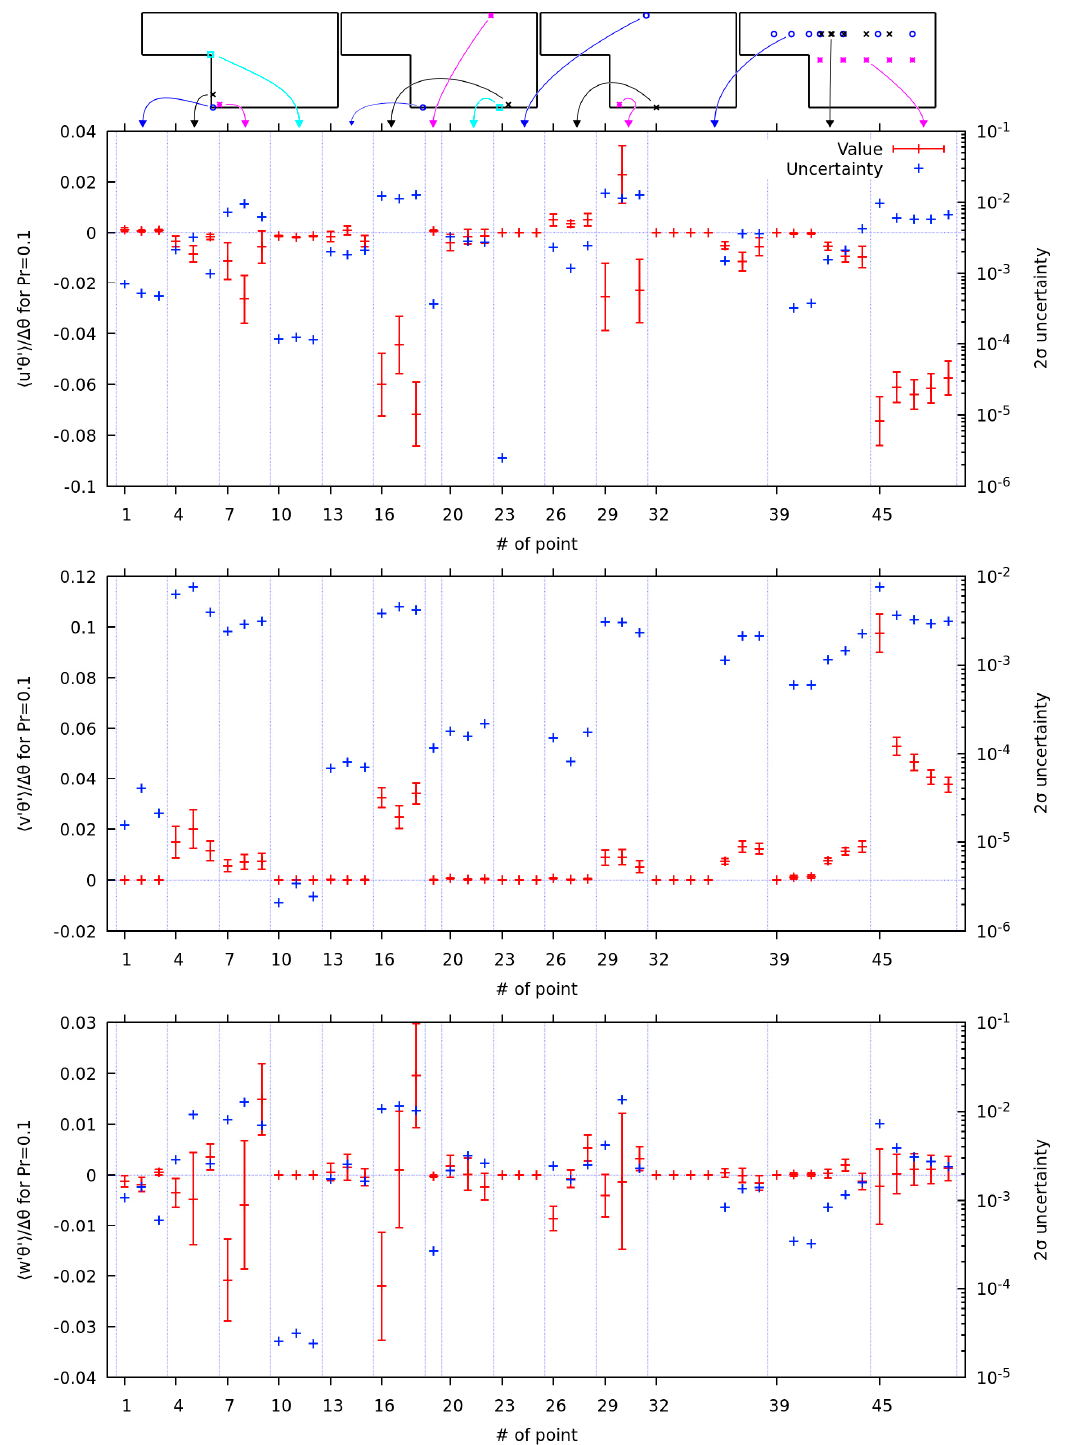
Figure A3. 𝑥 -axis: number of point according to Figure 2 . Top to bottom: turbulent heat flux components for Pr = 0.1 : Figure A3. x -axis: number of point according to Figure 2 . Top to bottom: turbulent heat flux components for Pr = 0.1: 〈𝑢 (cid:4593) 𝜃 (cid:4593) 〉 , 〈𝑣 (cid:4593) 𝜃 (cid:4593) 〉 and 〈𝑤 (cid:4593) 𝜃 (cid:4593) 〉 . Red dots represent root-mean-square values with ± 2𝜎 range (left scale), green dots represent (cid:104) u (cid:48) θ (cid:48) (cid:105) , (cid:104) v (cid:48) θ (cid:48) (cid:105) and (cid:104) w (cid:48) θ (cid:48) (cid:105) . Red dots represent root-mean-square values with ± 2 σ range (left scale), green dots represent (2 σ ) ( 2𝜎 ) uncertainty (right scale). uncertainty (right